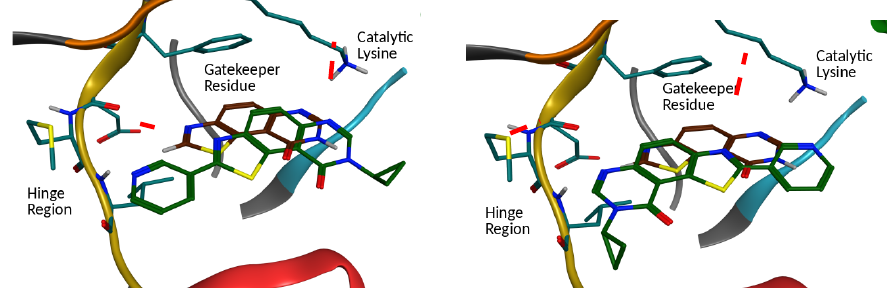
Figure 2. Predicted binding mode of FC162 by docking calculation. Left , first predicted binding mode (green), with the same orientation of the skeleton, but slightly shifted. Right , second predicted binding mode, in which the skeleton is flipped compared to its initial placement (in brown).